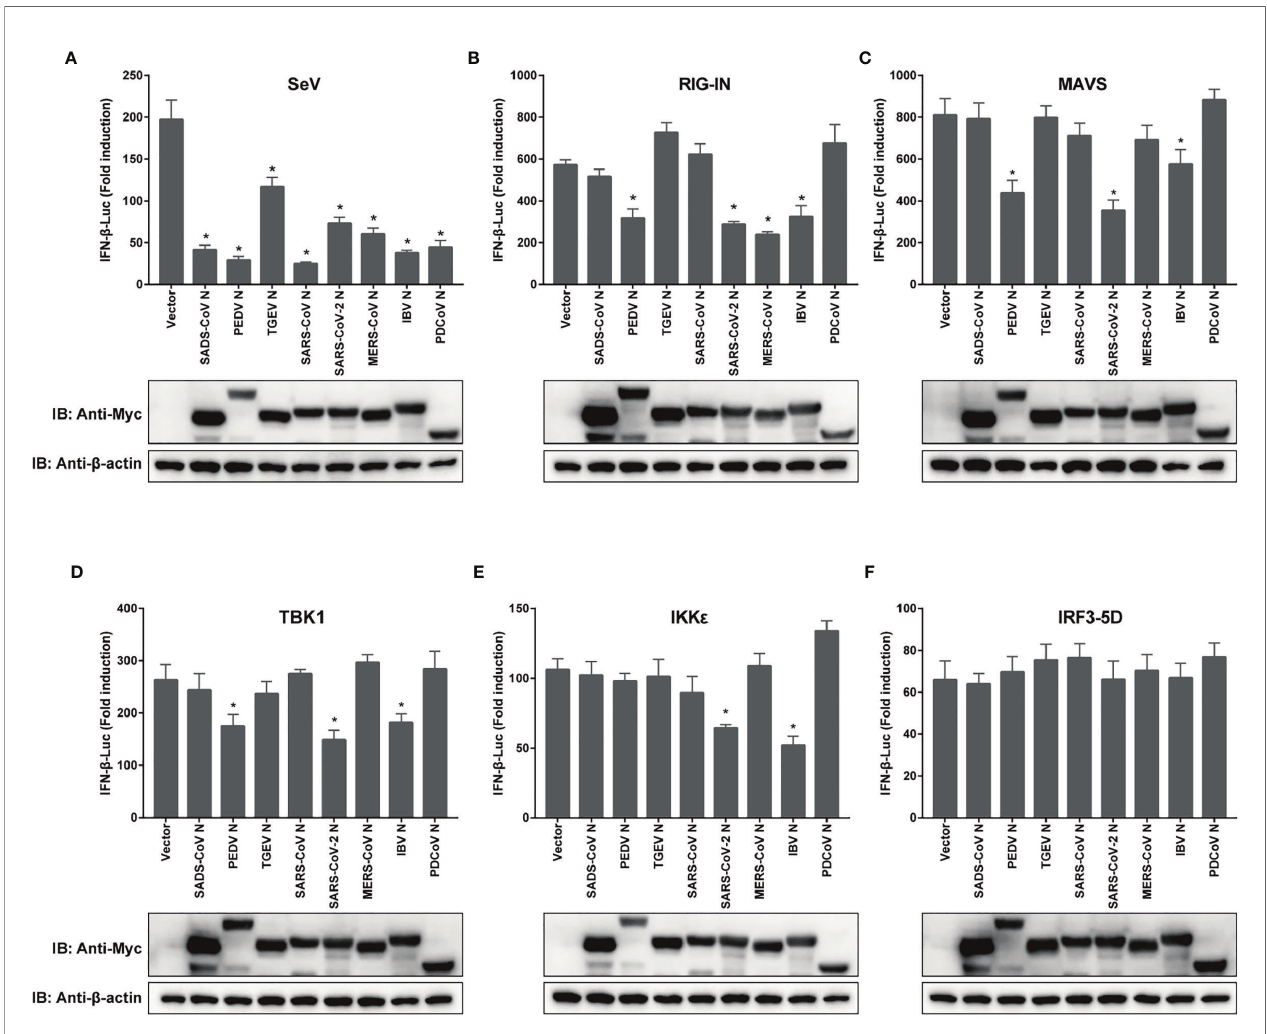
FIGURE 2 | Coronaviral N proteins antagonize IFN- b promoter activation via the RLR signaling pathway. 293T cells were transfected with expression vectors carrying IFN- b -Luc, RL-TK, and indicated CoV N genes for 12 h prior to SeV infection (A) , or cotransfected along with constructs expressing RIG-IN (B) , MAVS (C) , IKK ϵ (D) , TBK1 (E) or IRF3-5D (F) . Luciferase activity was measured at 24 h post-transfection or 12 h after SeV infection. IFN- b activity is expressed as the fold change of fi re fl y luciferase activity normalized by renilla luciferase activity compared to the empty vector control. The expression of N protein for each experiment was determined by western blotting. All experiments were performed three times, and pairwise differences in means were analyzed with Student ’ s t-test; *p <